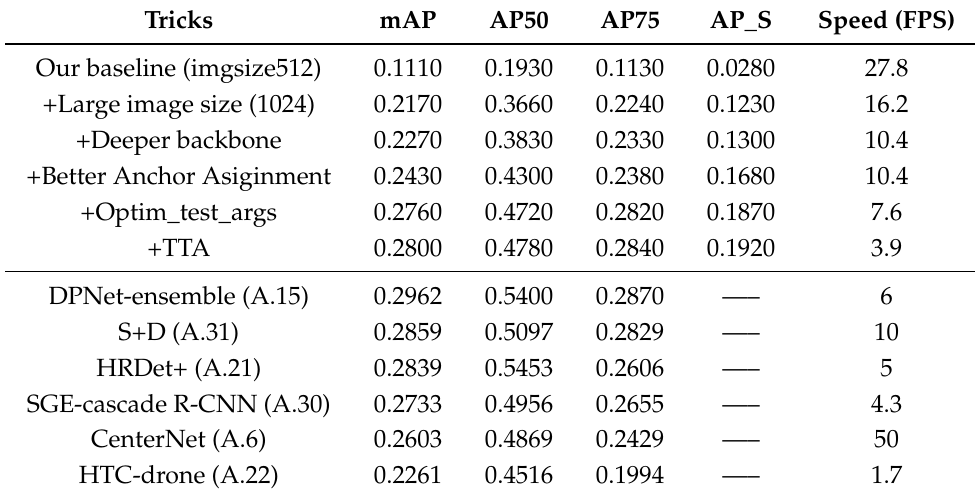
Table 6. The results of our baseline with some tricks compared to methods in [44]. Among these tricks, ” Optim _ test _ args ” means to use optimal testing arguments. TTA is test time augmentation. Tricks mAP